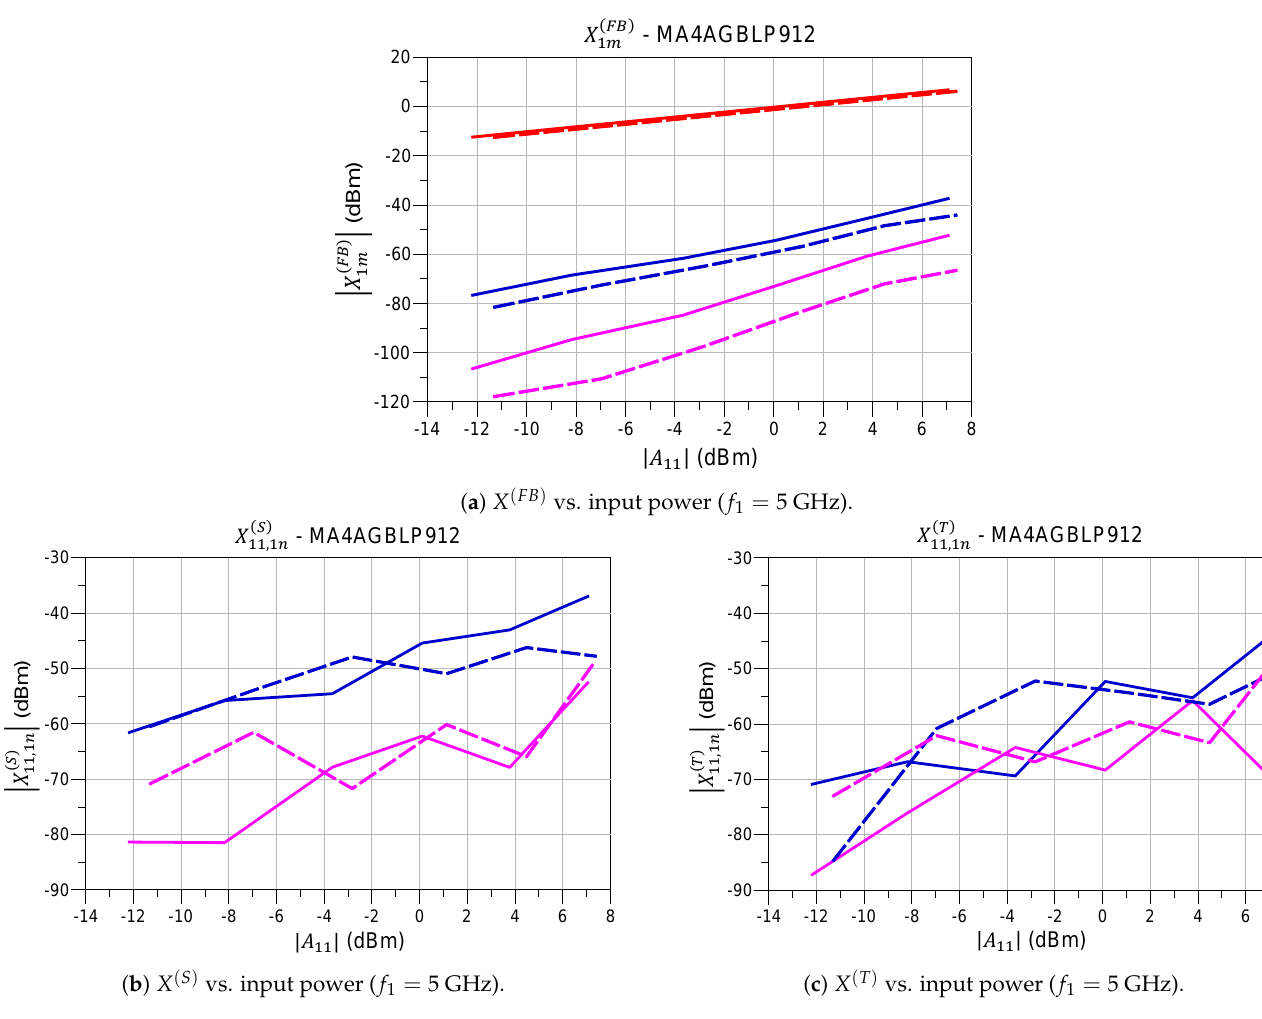
( b ) X ( S ) vs. input power ( f 1 = 5 GHz). ( c ) X ( T ) vs. input power ( f 1 = 5 GHz). Figure 4. X -Parameters variation with input power at fundamental f 1 = 5 GHz. ( f 1 , 2 f 1 , 3 f 1 , “Off”,